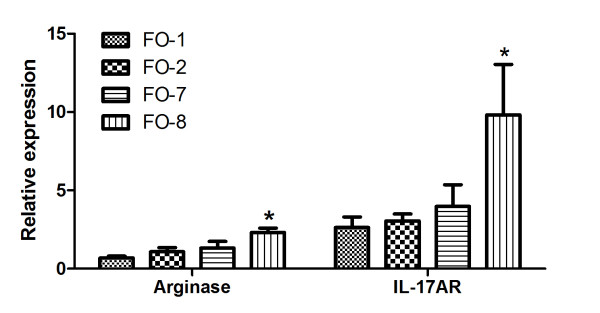
Arginase and IL17AR genes expressed in the head kidney of Atlantic salmon injected with different oil-based vaccines. qPCR expression studies of arginase and IL17A receptor (IL17AR) identified as upregulated by microarray. FO-1 = A. salmonicida (sc); FO-2 = A. salmonicida (6 × sc); FO-7 = M. viscosa (sc); FO-8 = M. viscosa (6 × sc). Gene expression ratios normalized to EF1α. Error bars = SE, n= 7. *p < 0.05.